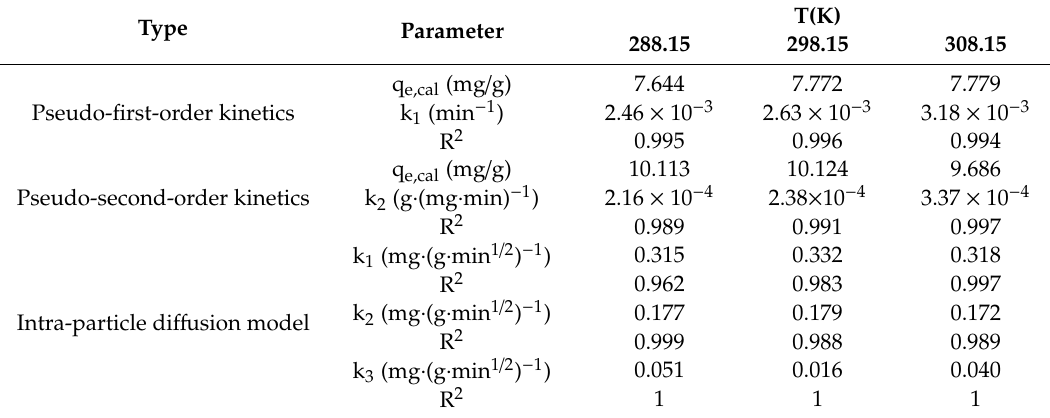
Table 1. Fitting parameters of adsorption